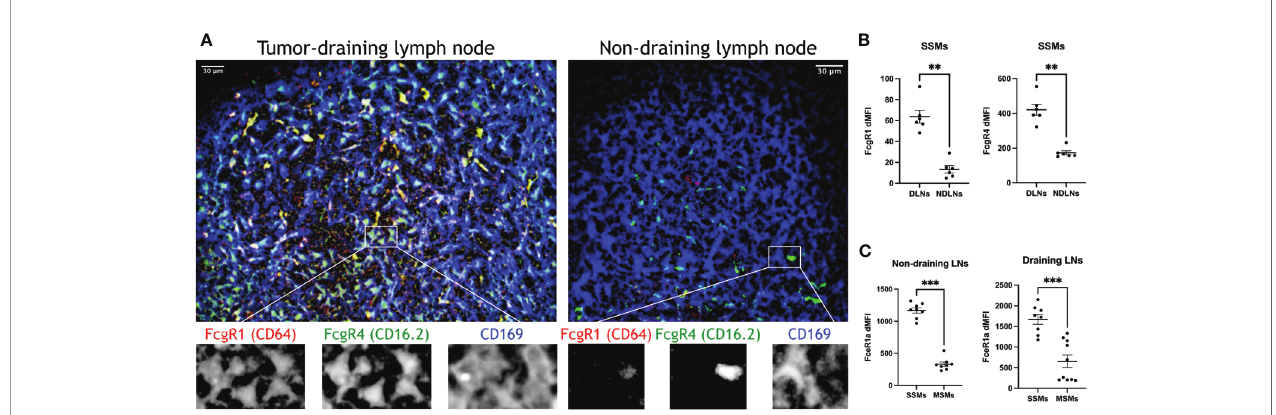
FIGURE 5 | Con fi rmation of top differentially expressed genes in SSMs. (A) Optical section (4.4um) of sub-capsular regions projected from a 3D reconstruction of tumor-draining and non-draining lymph nodes (tdLNs and ndLNs) from mice bearing MOC2 tumors. FcgR1 and FcgR4 were expressed only in SSMs from tdLNs, as compared to SSMs from ndLNs, exceeding the expected upregulation measured by sequencing ( Figure 4D ). Single color details of the highlighted region are shown at the bottom, to con fi rm co-localization. Images are representative of ~50um-deep 3D volumes (n = 2). Scale bar: 30um. (B, C) Flow cytometric analysis of tdLNs and ndLNs from mice bearing MOC2 tumors. As expected ( Figure 4D ), FcgR1 and FcgR4 were upregulated in SSMs from tdLNs, as compared to SSMs from ndLNs (B) . As expected ( Figures 2F , 4D ), FceR1a was upregulated in both ndLNs (left panel) and tdLNs (right panel) SSMs, as compared to MSMs from corresponding lymph nodes (C) . Expression intensity (dMFI) was calculated by subtracting intensity of fl uorescence minus one controls. SSMs and MSMs were gated as in Figure 1 . Statistical test by Mann-Whitney test. (**p < 0.01; ***p <